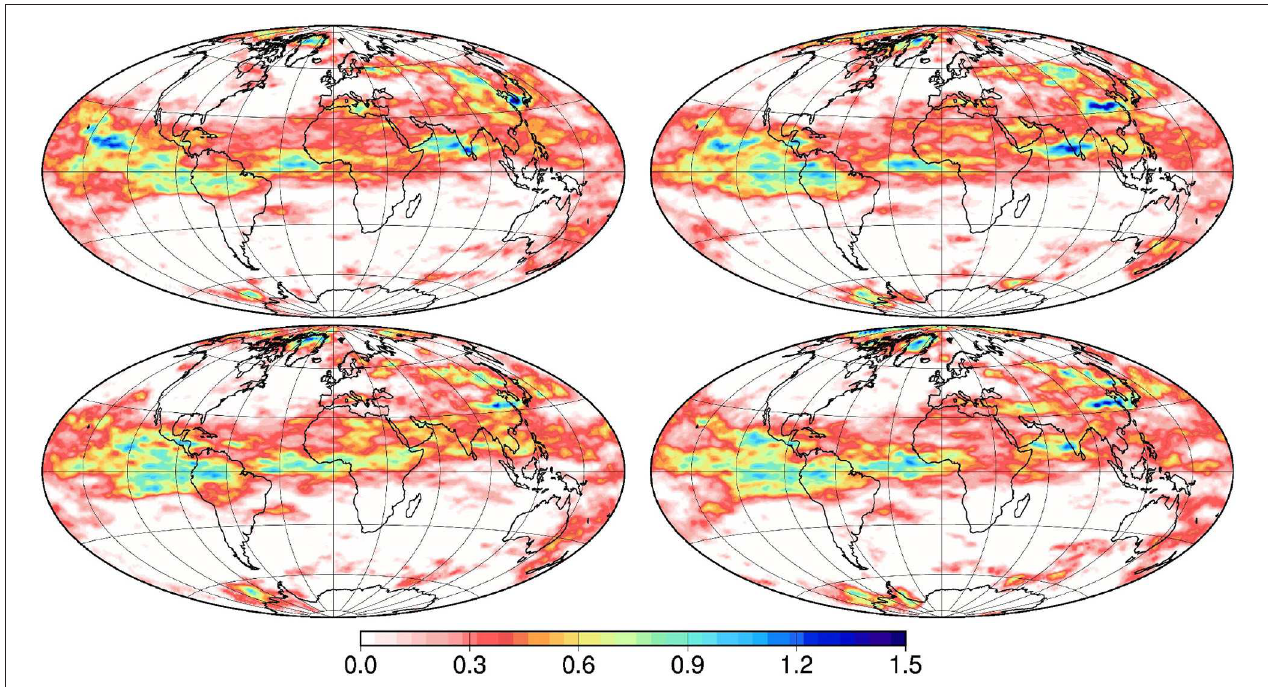
FIGURE 8 | Sample of 4 vectors x from the updated